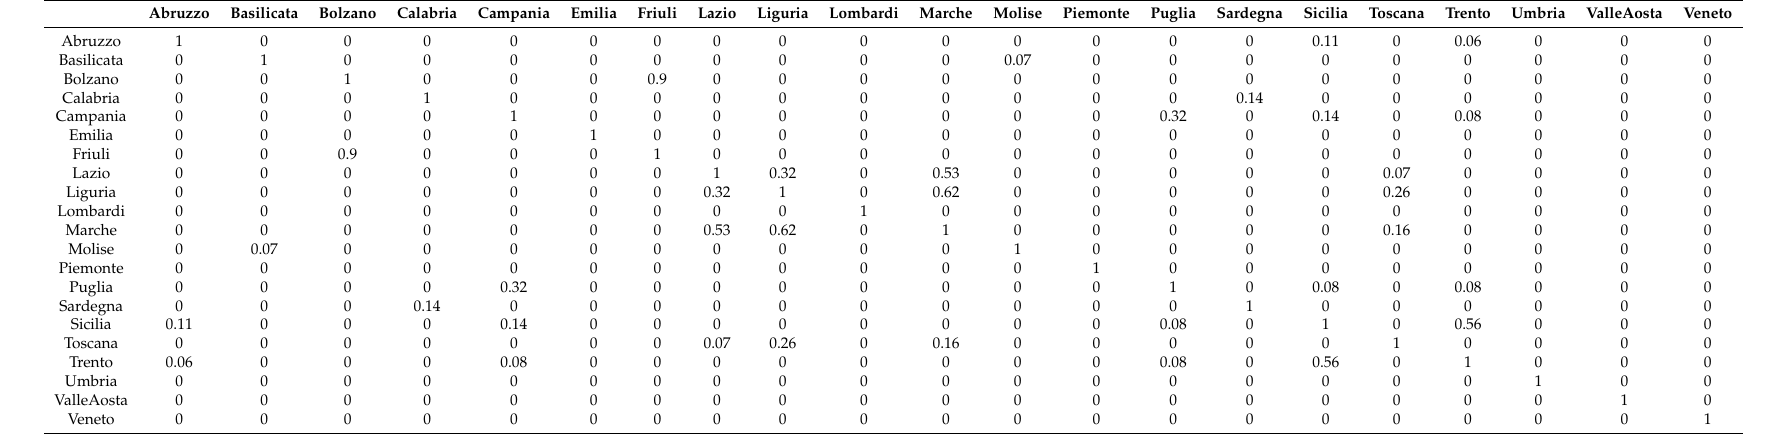
Table A6. Similarity values of Hospitalized with Symptoms network in the fifth